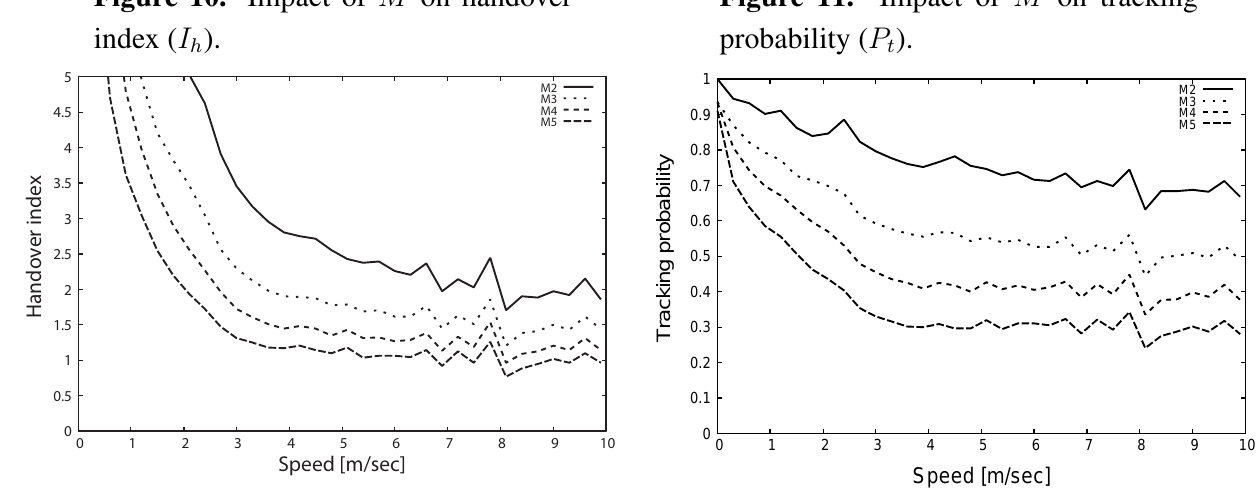
Figure 11. Impact of M on tracking probability ( P t